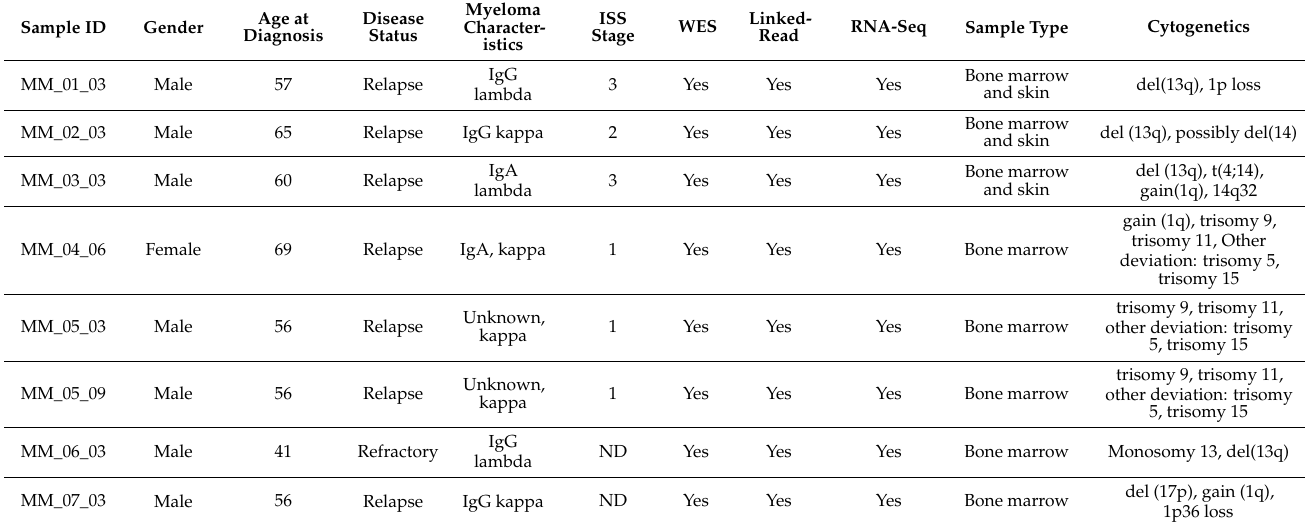
Table 1. Clinical characteristics of the multiple myeloma